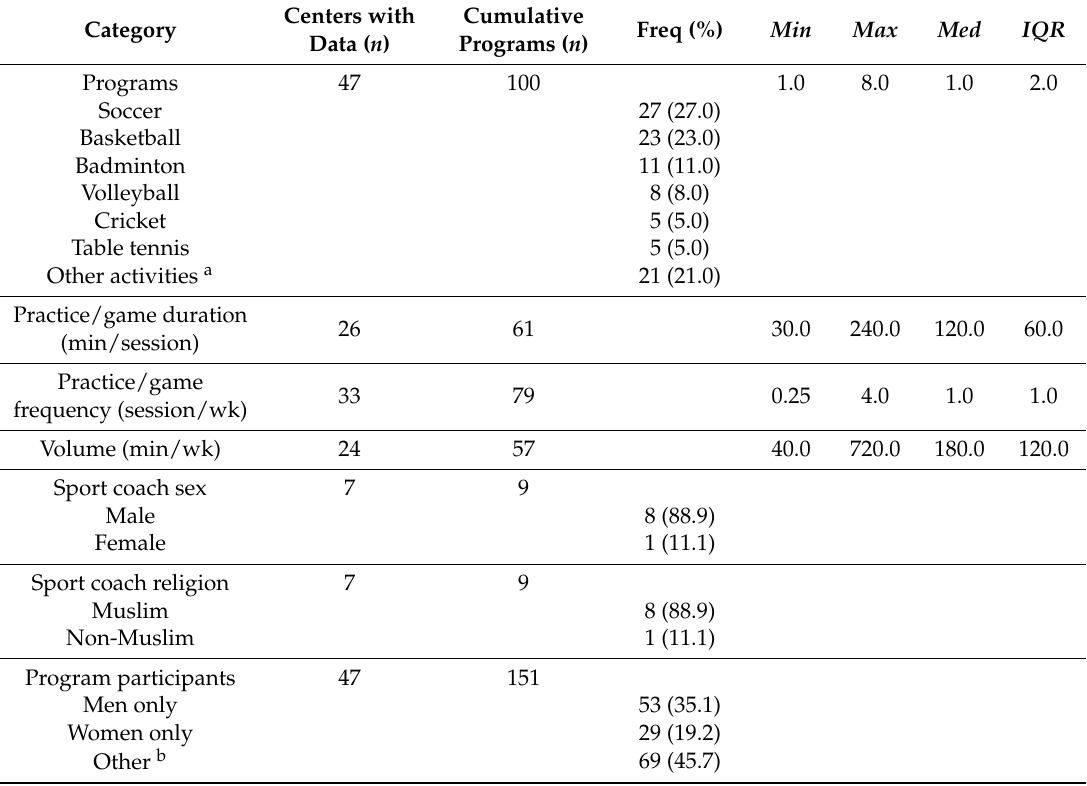
Table 3. Islamic center sports program descriptive data ( n = 47 centers).